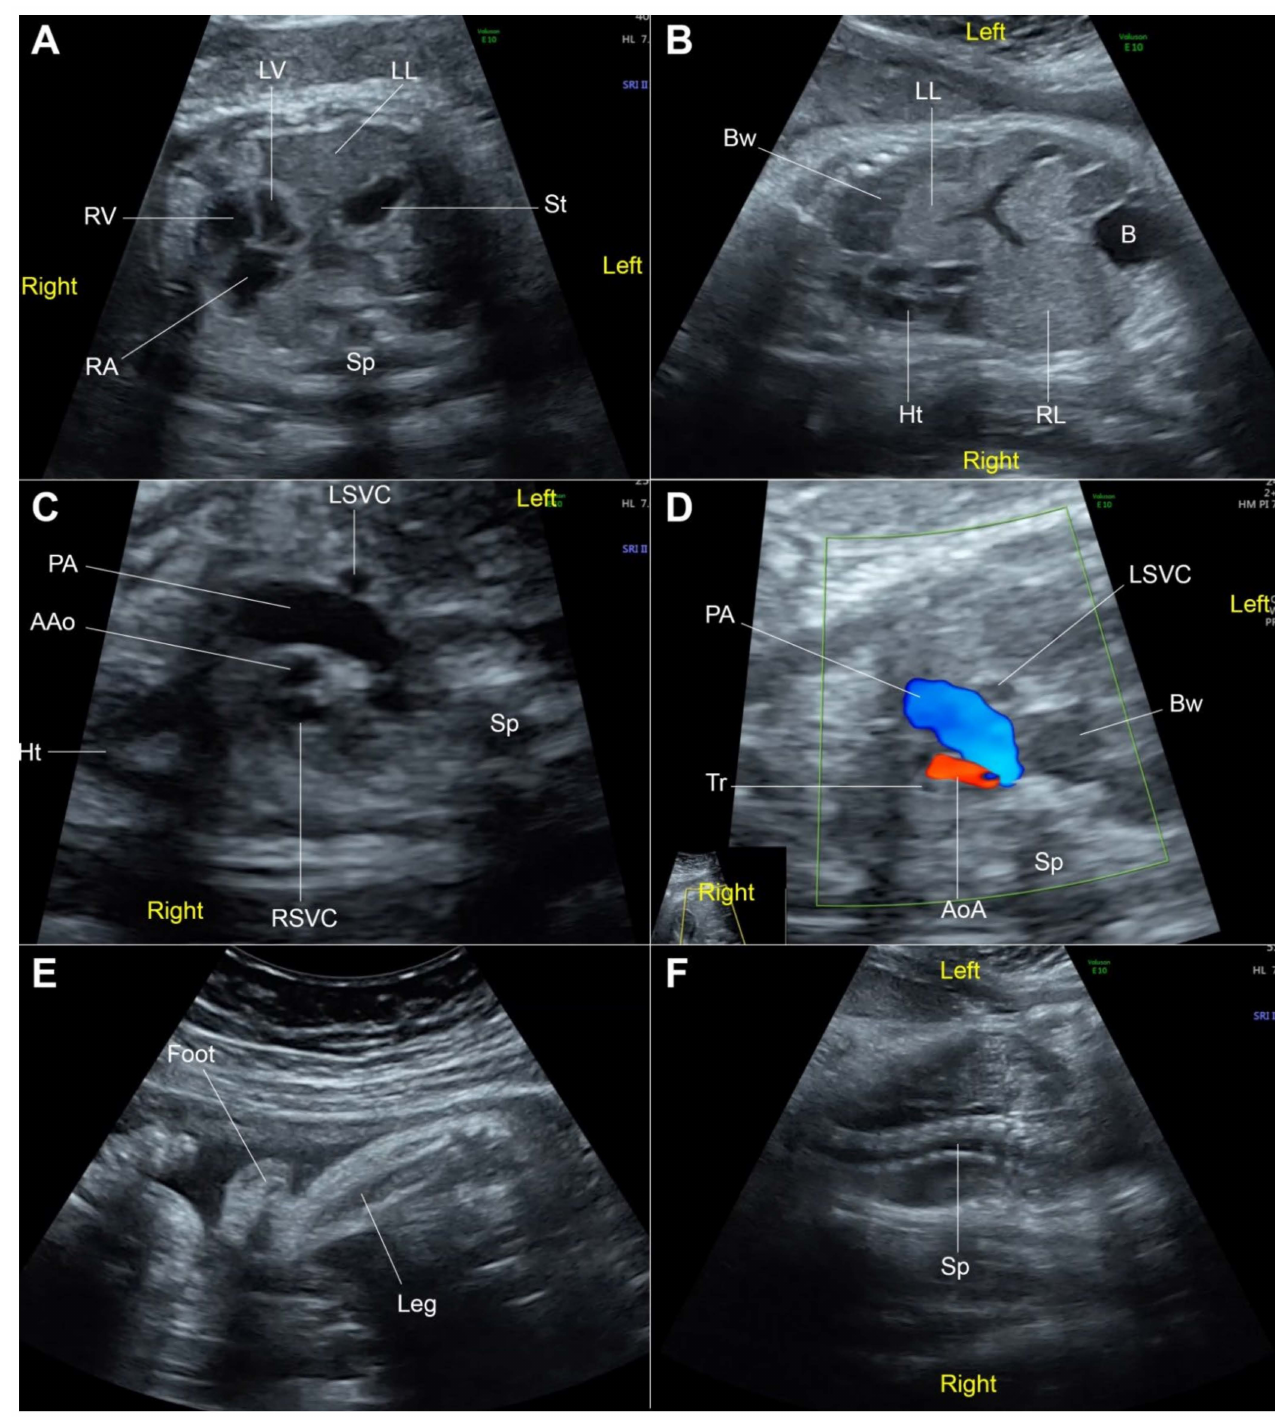
Figure 1. Fetal ultrasound at 32 weeks of gestation; ( A ) Cross-section at four-chamber view: the heart in the right chest with left-right disproportion, stomach (St) and liver (left lobe: LL) located in the left chest; ( B ) Coronal view of the trunk: the heart (Ht) in dextroposition, left lobe of the liver and part of portal vein located in the left chest; ( C ) Three-vessel view: small ascending aorta (AAo) and left superior vena cava (LSVC); ( D ) Three-vessel and trachea view: retrograde flow in the small aortic arch (AoA); ( E ) Talipes-equinovarus; ( F ) Scoliosis (B: bladder; Bw: bowel; LV: left ventricle; PA: pulmonary artery; RA: right atrium; RL: right lobe of the liver; RSVC: right superior vena cava; RV: right ventricle; Sp: spine; Tr: